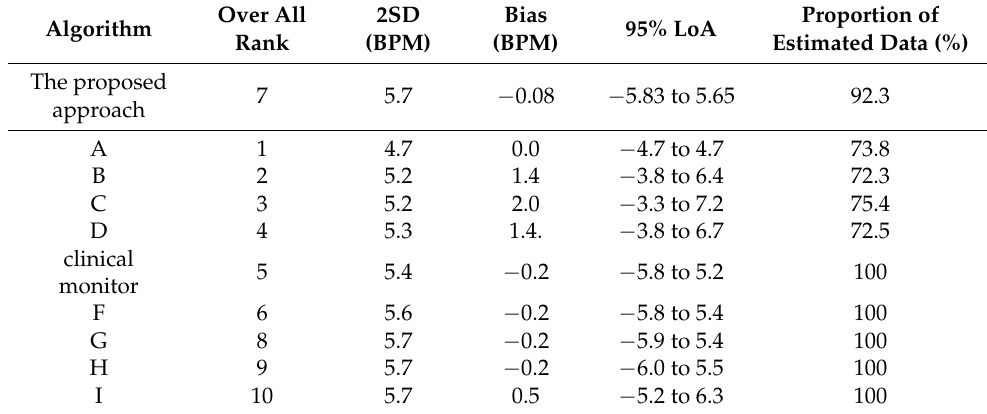
Table 7. The comparison of using EEMD-SDF and other methods in limits of agreement